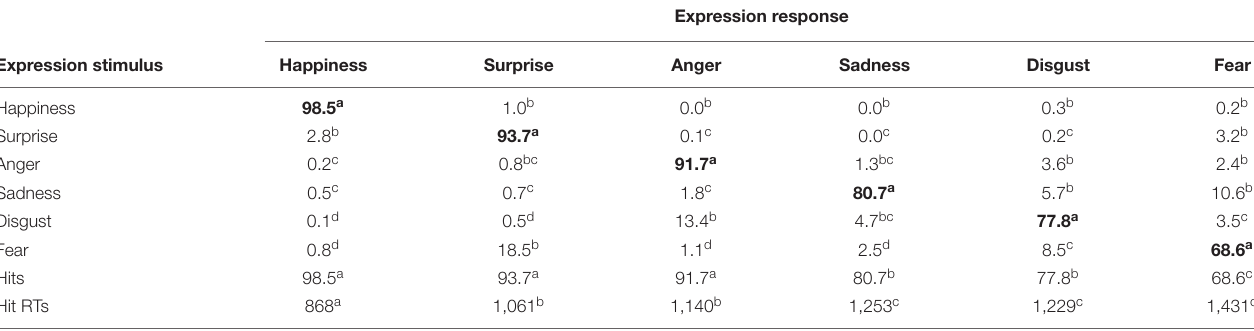
TABLE 1 | Mean proportion (%) of hits and confusions in human observers’ responses, and reaction times (for hits only) for each target (stimulus) expression.